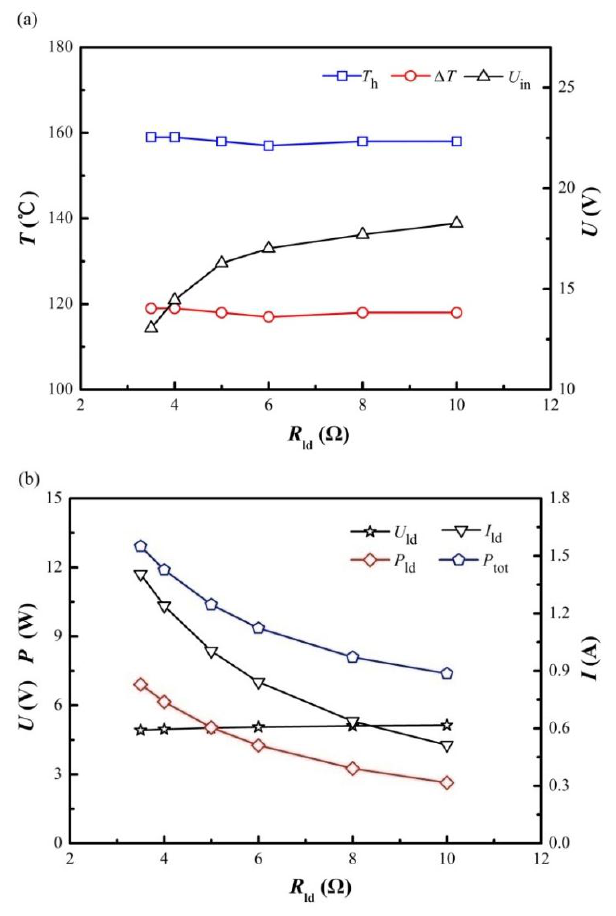
Figure 3. Results of the power load test of the SPTEG. ( a ) Hot end temperature, temperature difference, and input voltage of the DDC; ( b ) Load voltage, load current, load electric power, and total electric power.